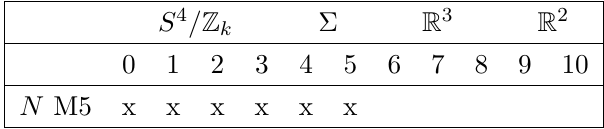
Table 1. M-theory background relevant for the AGT